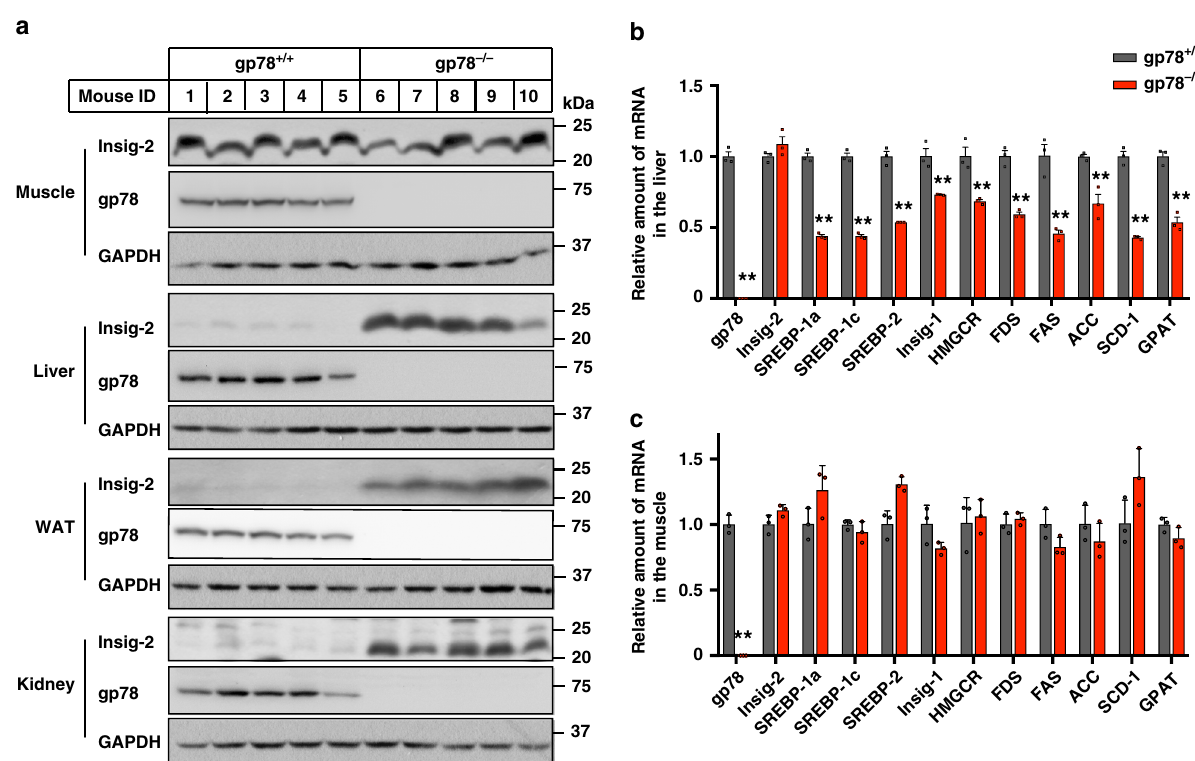
Fig. 1 Ablation of gp78 increases Insig-2 protein level in the liver, WAT and kidney but not in the muscle. Male gp78 − / − mice and their wild-type (WT) littermates ( gp78 + / + ) (8-week-old, n = 5 per group) were sacri fi ced and harvested for immunoblotting ( a ) and RT-qPCR ( b , c ) analysis. a Expression of indicated proteins in different tissues. b , c The mRNA levels of indicated genes in the liver ( b ) and muscle ( c ). Data are presented as mean ± s.d. ** p < 0.01, unpaired two-tailed Student ’ s t